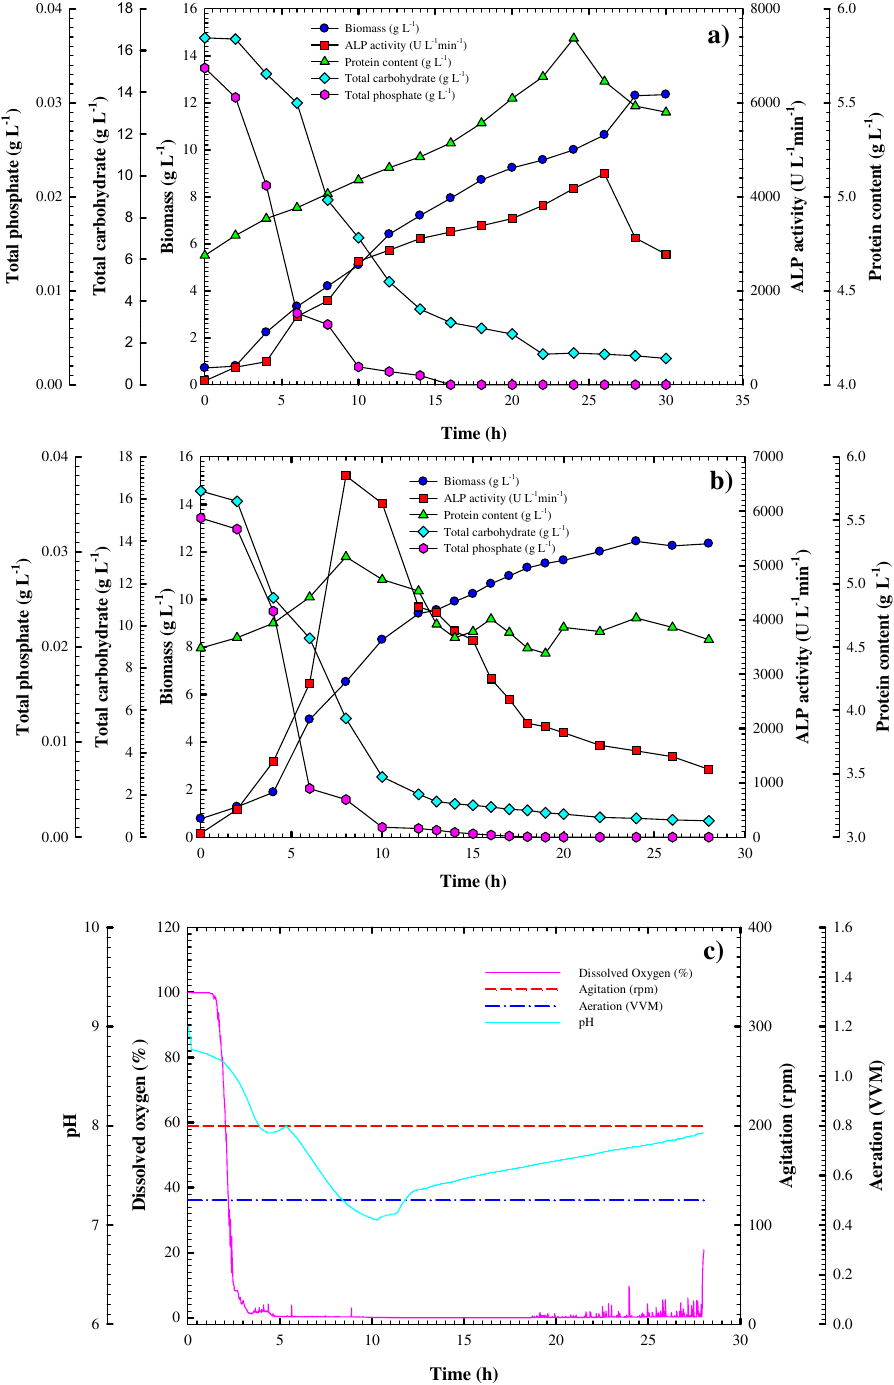
Figure 6. Monitoring of Bacillus paralicheniformis strain APSO growth and ALP productivity ( a ) at shake- flask scale cultivation and ( b ) in a 7-L stirred tank bioreactor under uncontrolled pH conditions. ( c ) On-line data (dissolved oxygen, agitation, airflow rate, and pH) as a function of time during batch fermentation in the bioreactor under uncontrolled pH